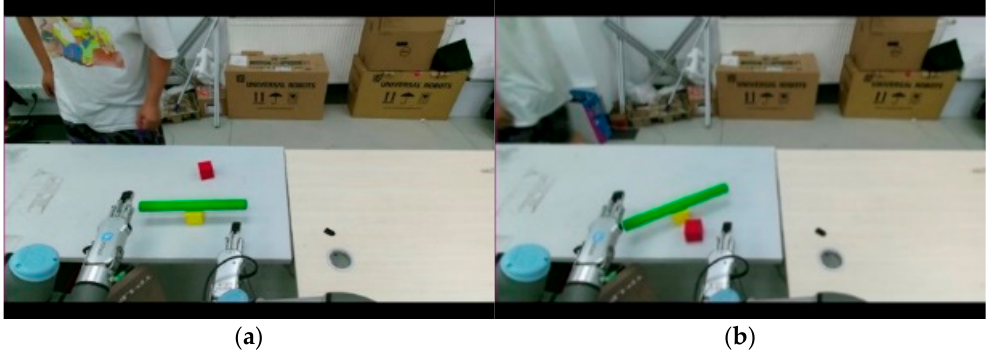
Figure 9. The dataset of Mask-RCNN algorithm. ( a ) and ( b ) Two pictures were randomly selected to show the unlabeled images of thin rods in different positions and angles in the dataset.